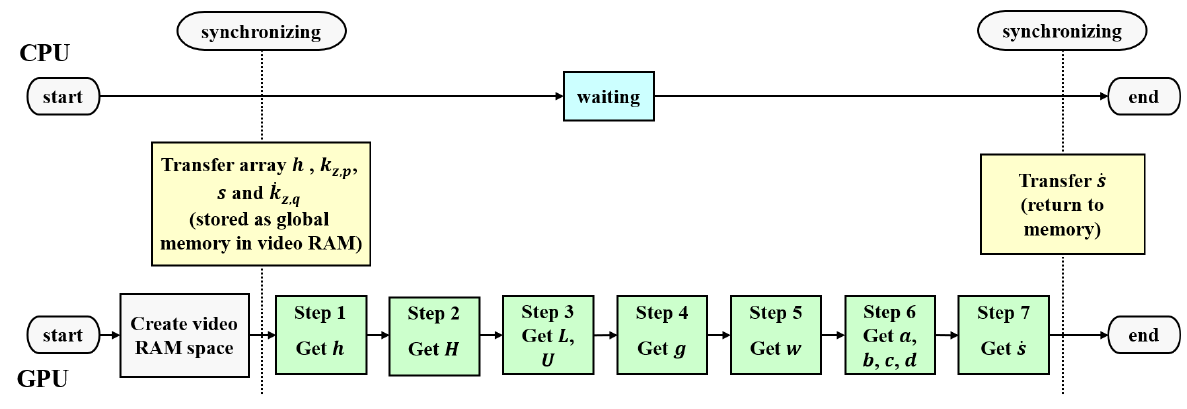
Figure 3. Cubic spline interpolation in the traditionally GPU-only